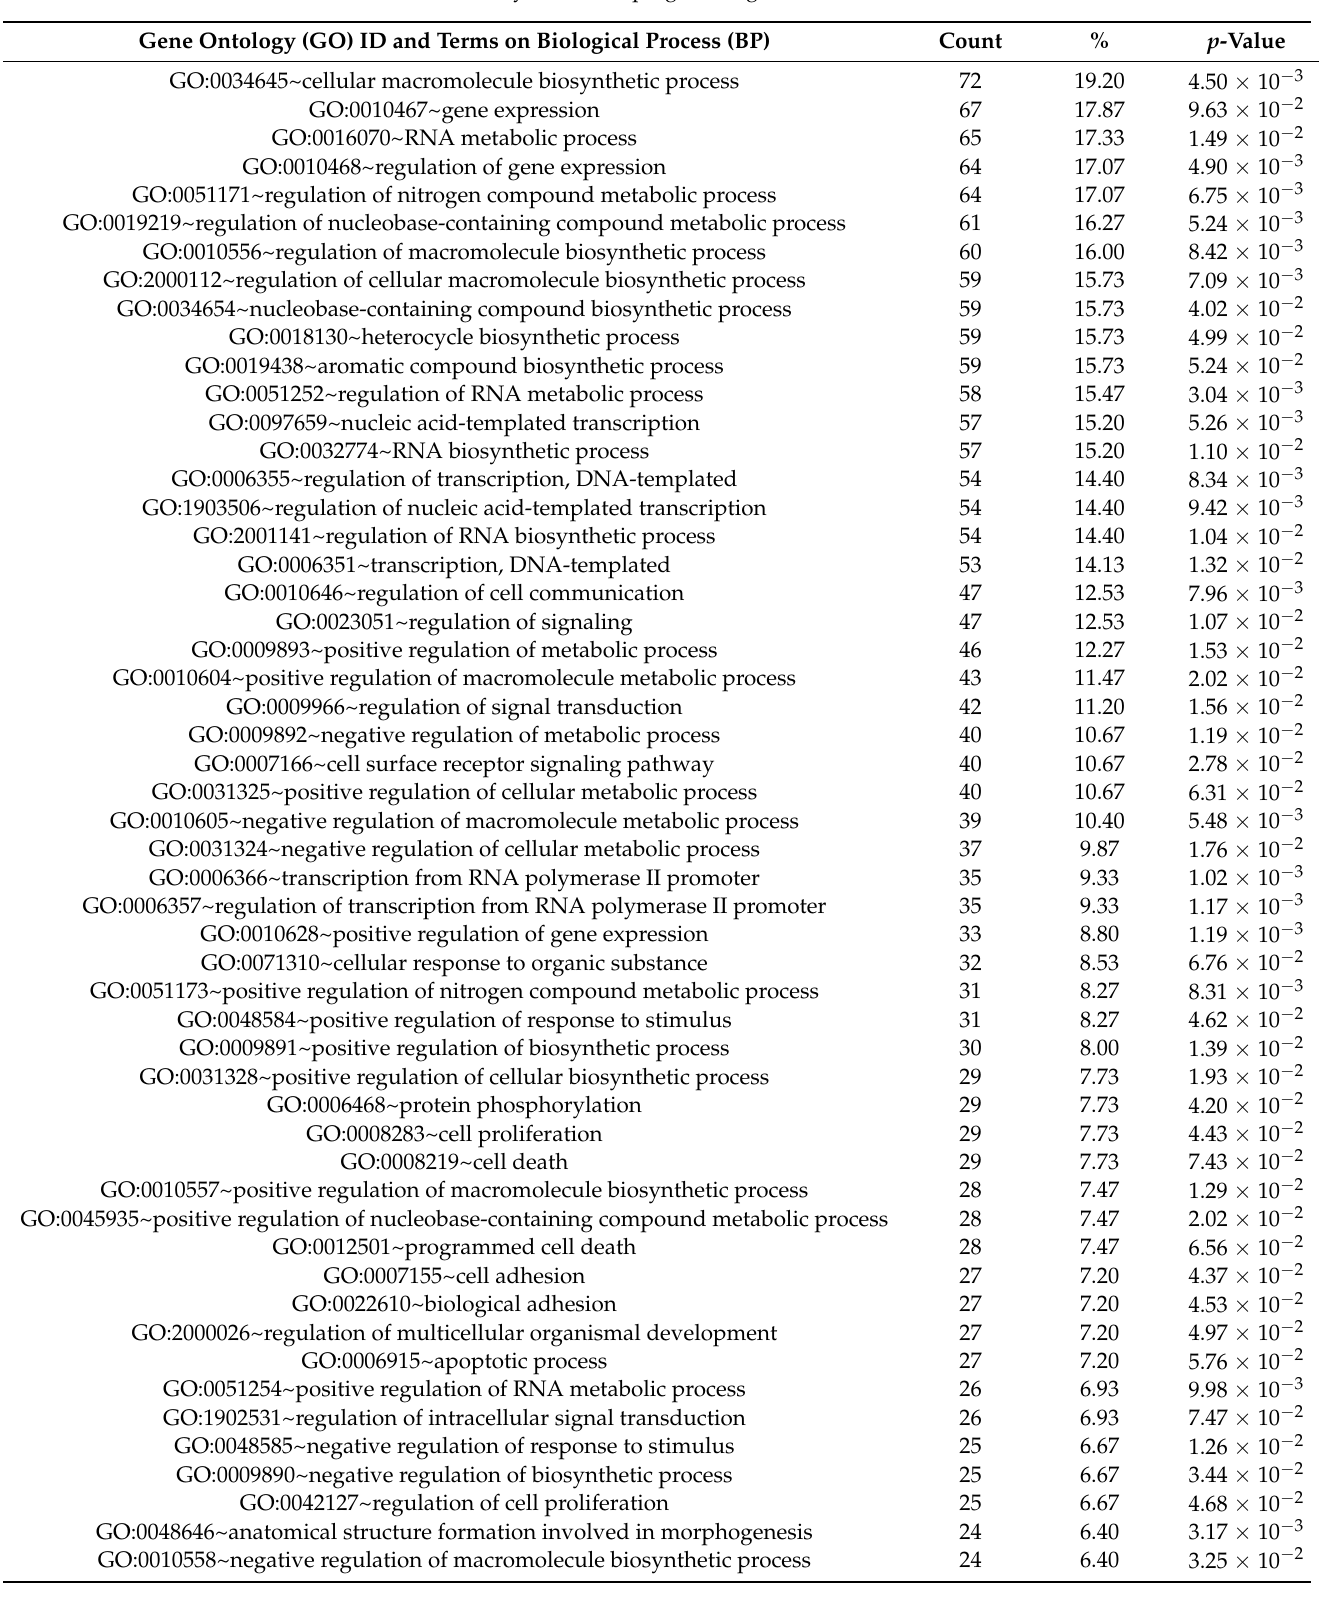
Table 5. The functional analysis of the upregulated genes at 6 h after LLL irradiation. Gene Ontology (GO) ID and Terms on Biological Process